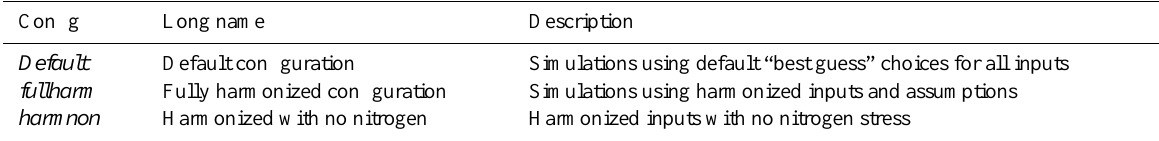
Table 3. General simulation configurations for Phase 1.